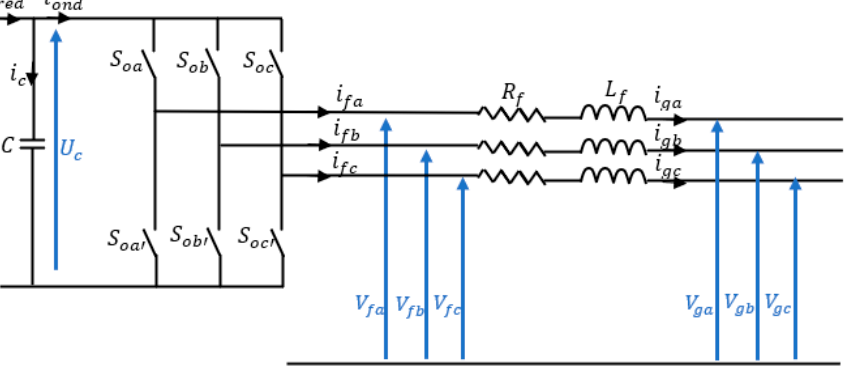
Figure 7. Grid-side